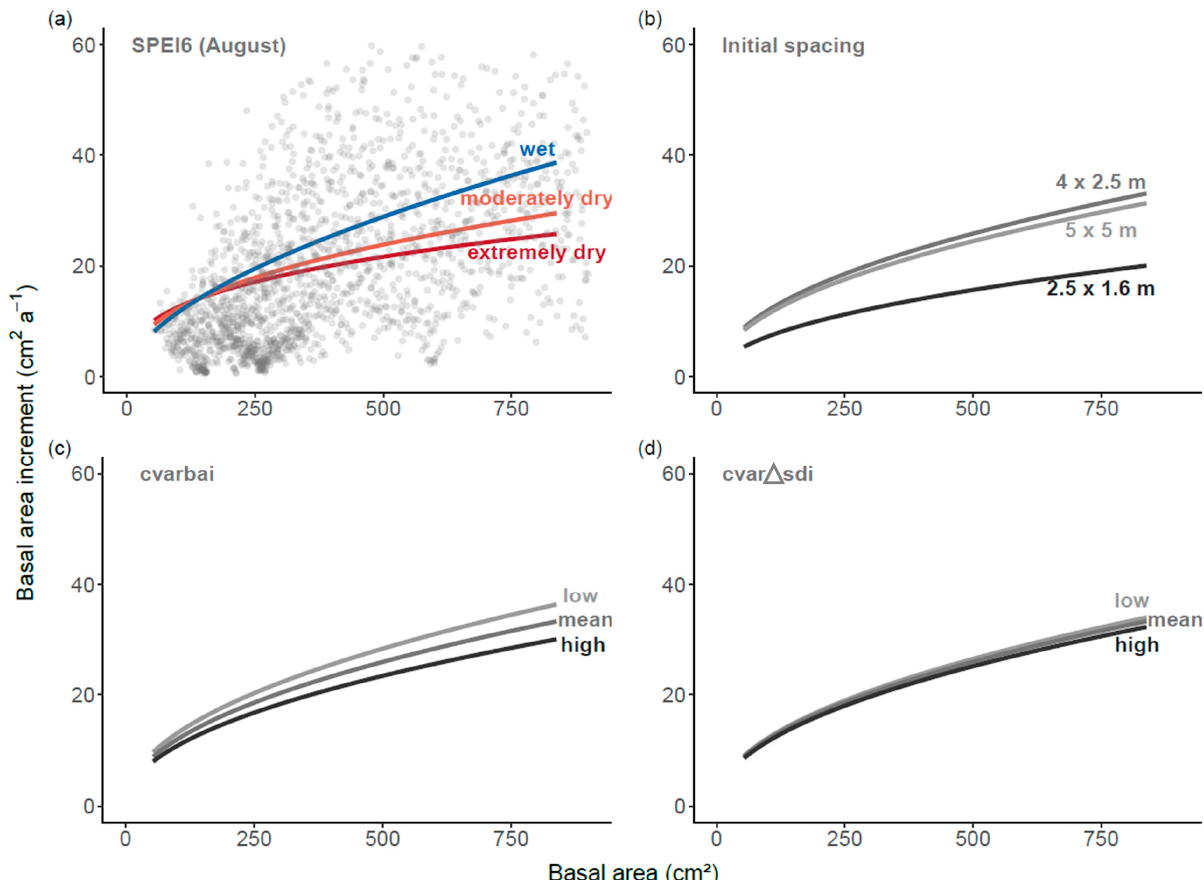
Figure 4. Effects of climatic conditions ( a ), initial spacing in 1974 ( b ), variation of previous growth ( c ), and of past changes in competition ( d ) on annual growth (y-axis). Each variable was predicted independently, while other variables were set to mean. For the categorical variable “initial spacing,” 4 × 2.5 m was chosen to predict other variables. The x-axis represents the range of basal area (cm 2 ) where 95% of the observations are located. These are exemplarily shown as gray dots in ( a ). The predictions for SPEI6 are based on the classifications by Slette et al. [89]. The chosen prediction levels for cvarbai and cvar ∆ sdi correspond to the mean and the respective upper and lower quantiles based on bootstrapping with 1000 iterations. The labels refer to the actual values (e.g., low = low values of cvarbai ).